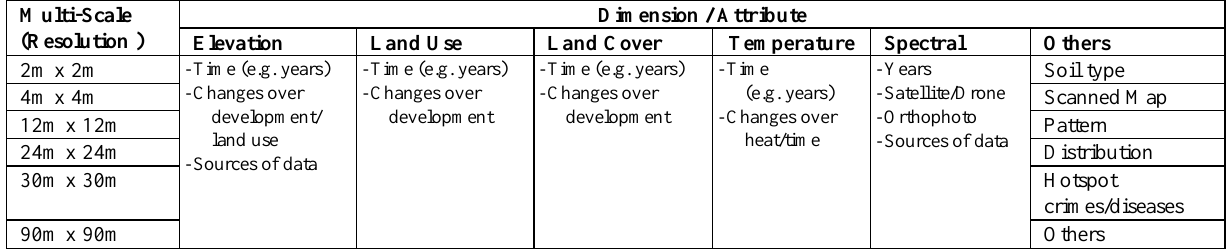
Table 1. Multi-scale dimension for